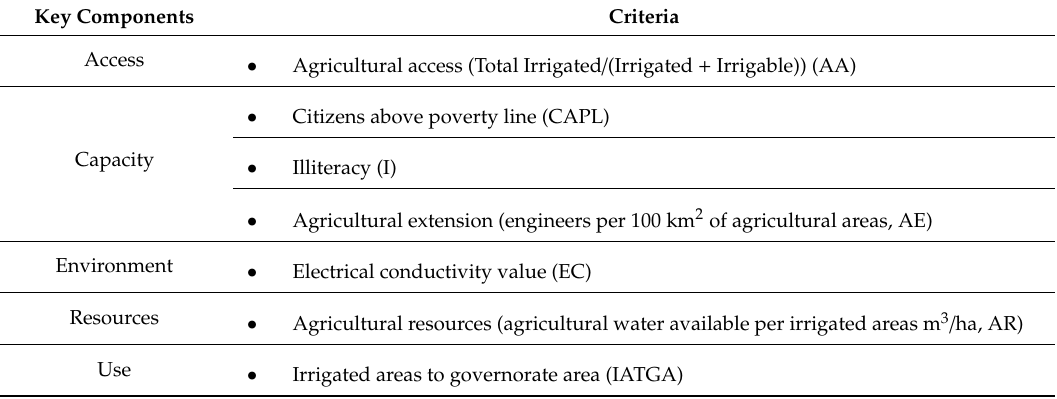
Table 2. Agricultural water poverty index (AWPI) key components and the associated criteria for the West Bank case study.